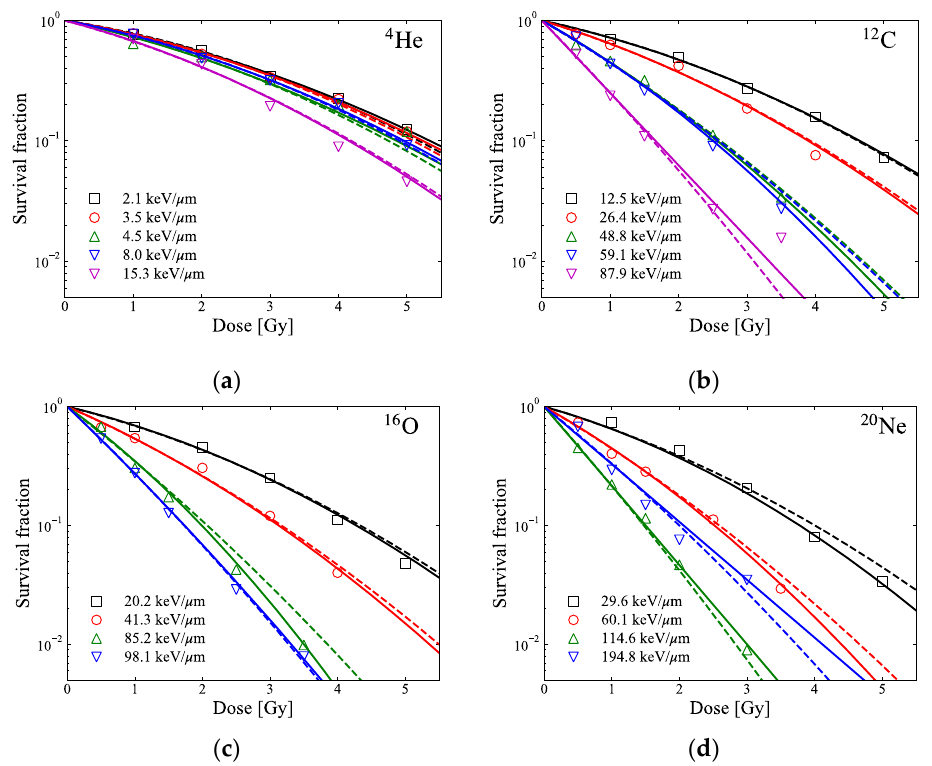
Figure 7. Markers show reported in vitro SF of HSGc-C5 cells for different LETs of pristine ( a ) 4 He-, ( b ) 12 C-, ( c ) 16 O-, and ( d ) 20 Ne-ion beams [15]. The lines represent the fitted survival curves based on the LQ model (solid lines: curves fitted with α and β set as free parameters; broken lines: curves fitted with α set as a free parameter and the constant β = 0.0474 Gy − 2 ).